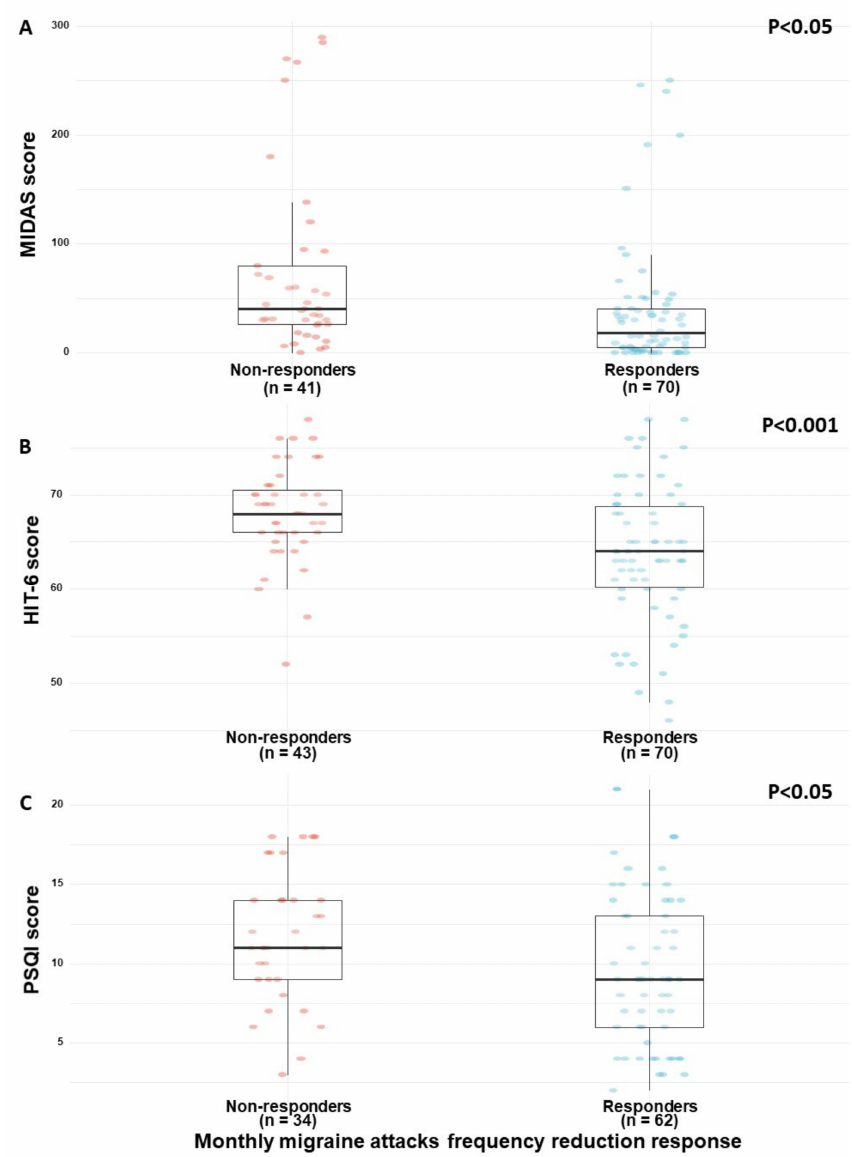
Figure 1. ( A – C ) Clinical di ff erences between responders and non-responders. Note: MIDAS, migraine index disability scale; HIT-6, headache impact test; PSQI, Pittsburgh sleep quality index. Response refers to reduction in the monthly frequency of migraine attacks following the initiation of MC treatment (i.e., ≥ 50%) compared to non-responders (i.e., <